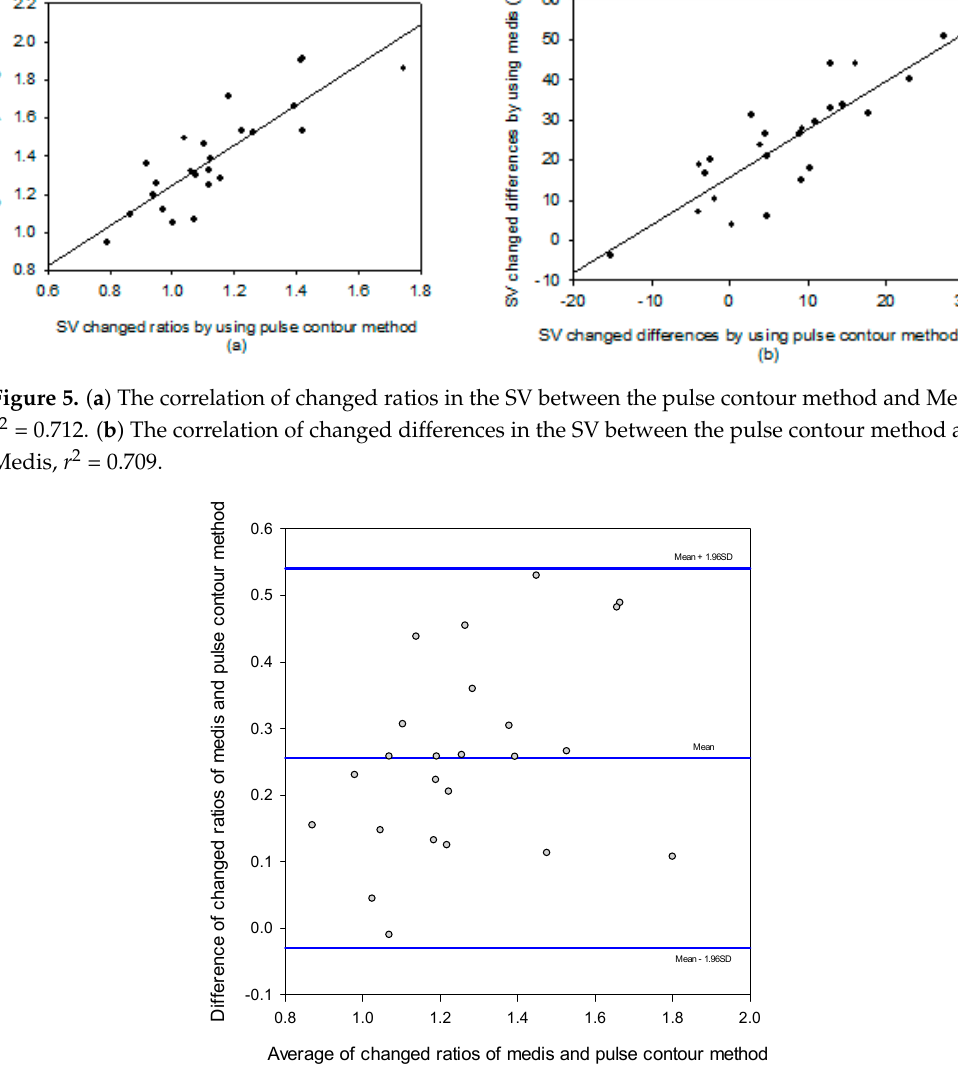
Figure 6. The Bland–Altman plot of the changed ratios of SV measurement using the pulse contour method and the Medis ® CS 1000. Mean: 0.256. Standard division (SD): 0.145. Limits of agreement: − 0.029 and 0.540.